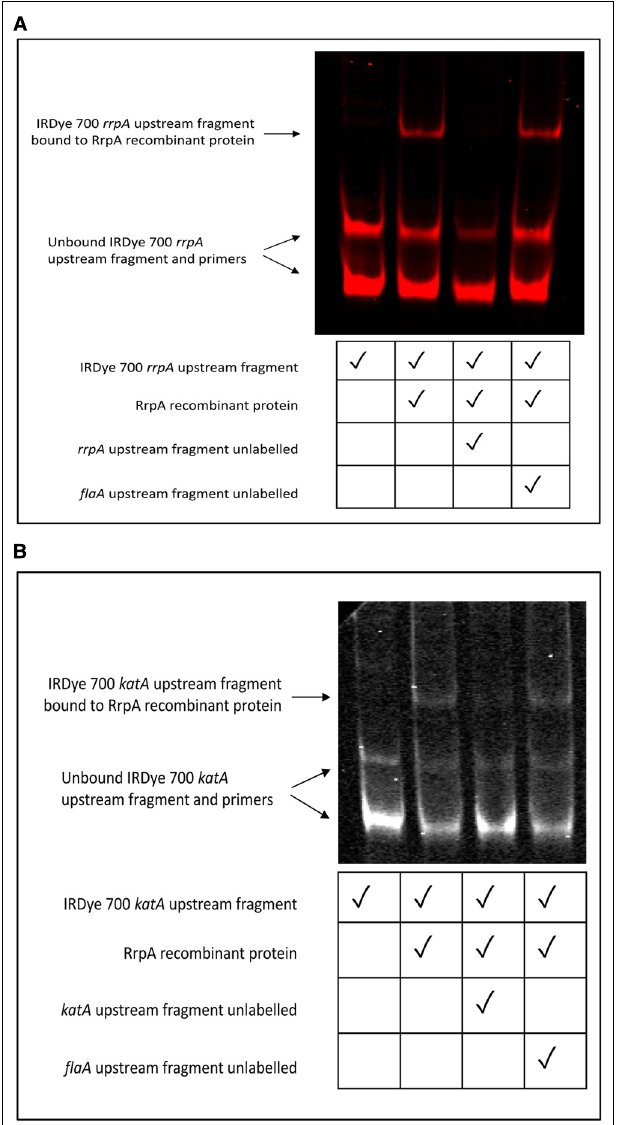
FIGURE 1 | Electrophoretic mobility shift assays (EMSAs) indicate that RrpA binds to a DNA promoter sequence upstream of the rrpA (A) and katA gene (B). EMSAs were performed for RrpA protein hybridized to a PCR amplified fragment upstream of rrpA or katA labeled with IRDye ® 700. 2.5 m g ( (cid:25) 175 pmol) recombinant native protein was hybridized with 20 ng of gel purified DNA using the Odyssey ® Infrared EMSA kit (LI-COR Biosciences). Unlabelled PCR amplified fragments upstream of either rrpA , katA , or flaA were included as controls. Separation was performed under non-denaturing conditions with samples loaded onto a 6% (w/v) DNA retardation gel.